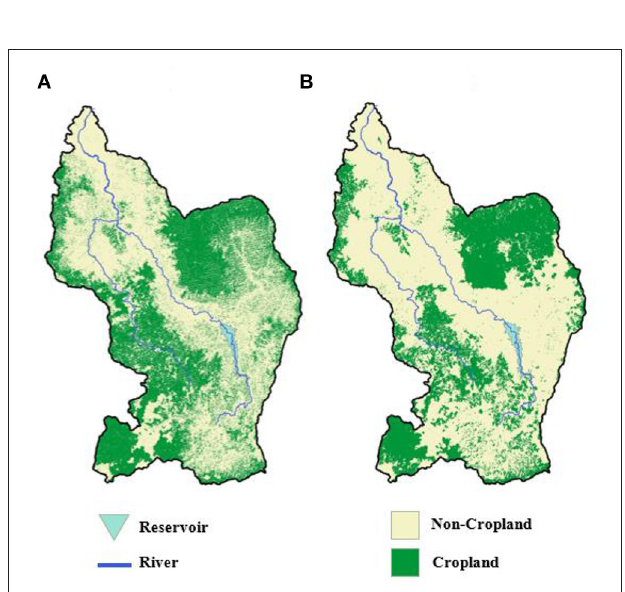
FIGURE 3 | (A) Cropland map sample produced for the Dhidhessa River whole basin in 2015. (B) Cropland reference map of GFSAD 30 for Dhidhessa River whole basin for 2015. Green color means cropland while yellow color means non-cropland.